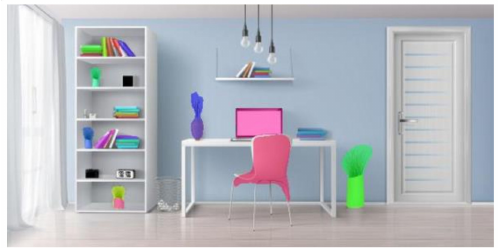
Figure 16. Output image keeping only the segmentation